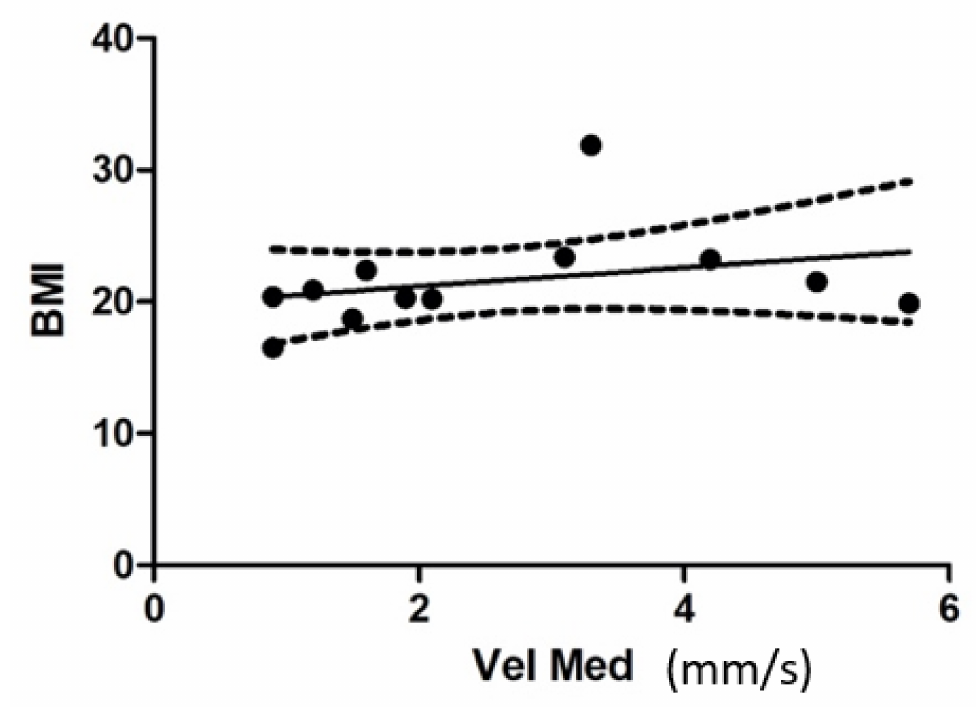
Figure 7. Correlation between the average speed (mm/s) with brace (WB) and the BMI. Dashed lines are 95%